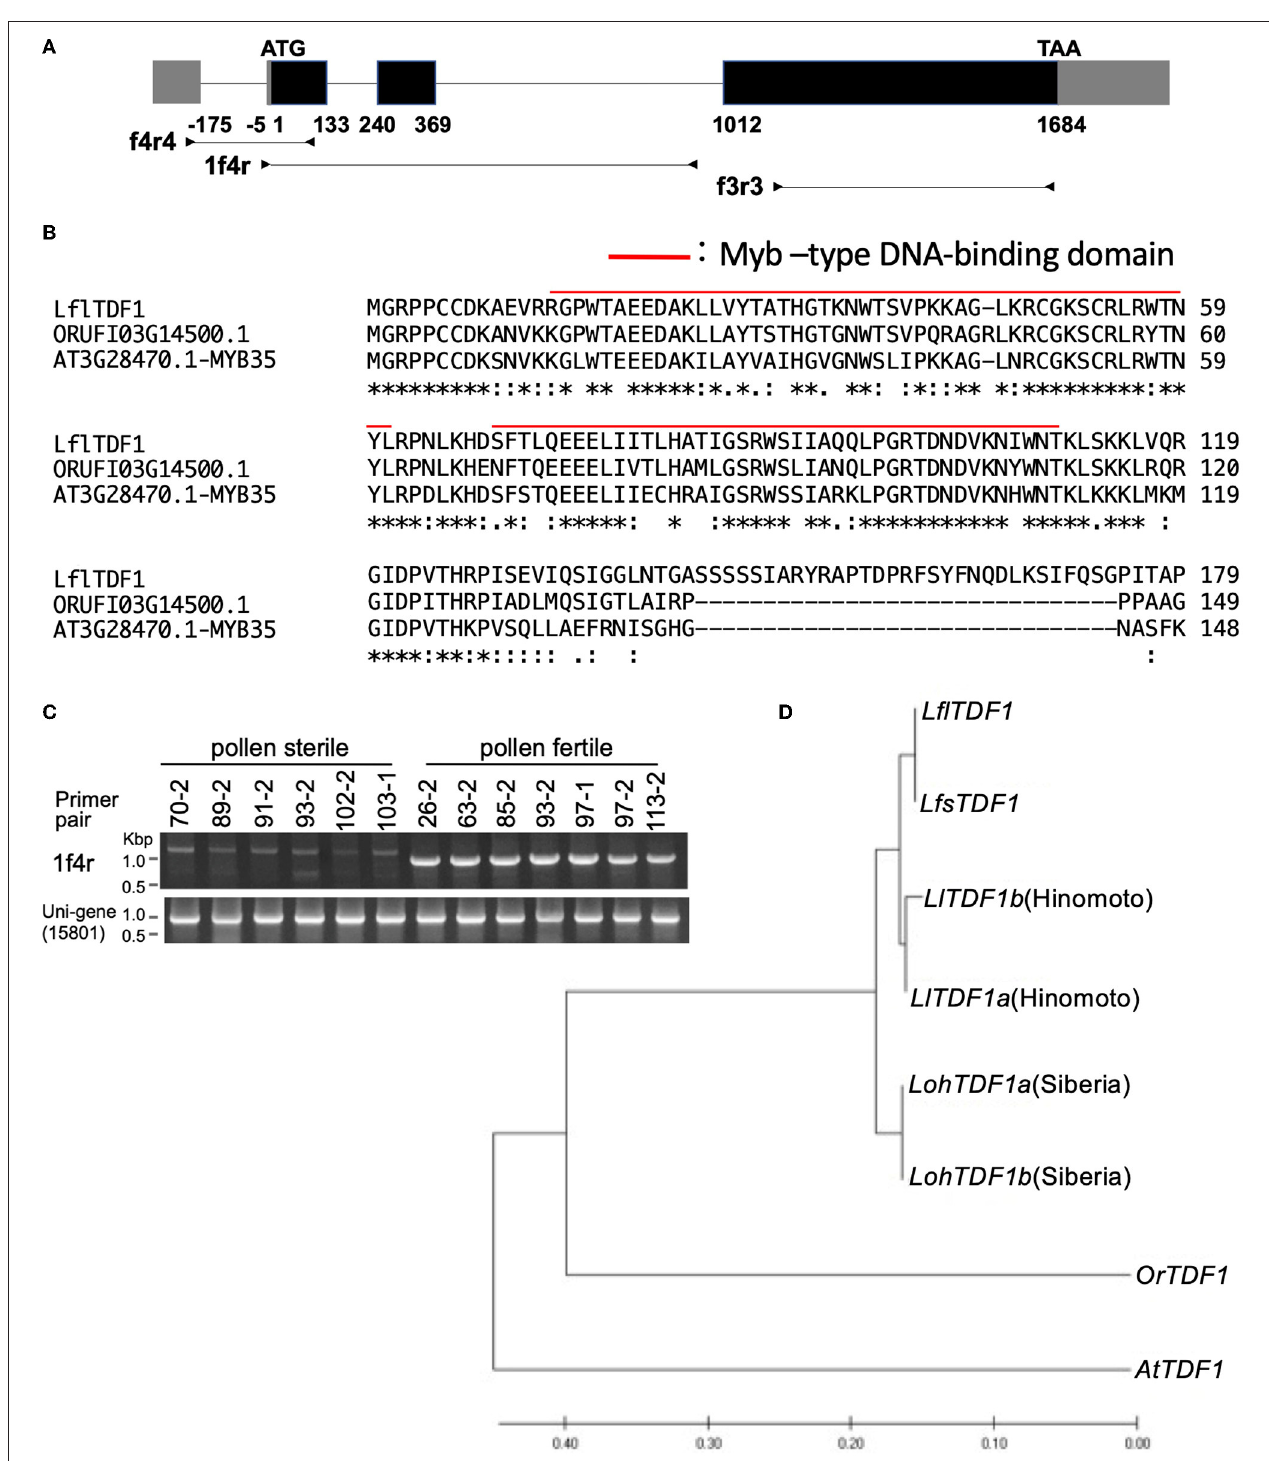
FIGURE 4 | (A) Schematic diagram of the LflTDF1 gene structure including exons (boxes) and introns (horizontal line). Gray and black boxes indicate untranslated and CDS region, respectively. Horizontal lines with attached arrowheads indicate PCR amplicon regions for genotyping with the intragenic markers. (B) Comparison of partial amino acid sequences of TDF1 orthologs in L . × formolongi , Oryza rufipogon (ORUFI03G14500.1), and Arabidopsis thaliana (AT3G28470.1), respectively. Red line indicates Myb–type DNA-binding domain predicted by Pfam. (C) An example of genotyping of LflTDF1 intragenic dominant marker, 1f4r, using the